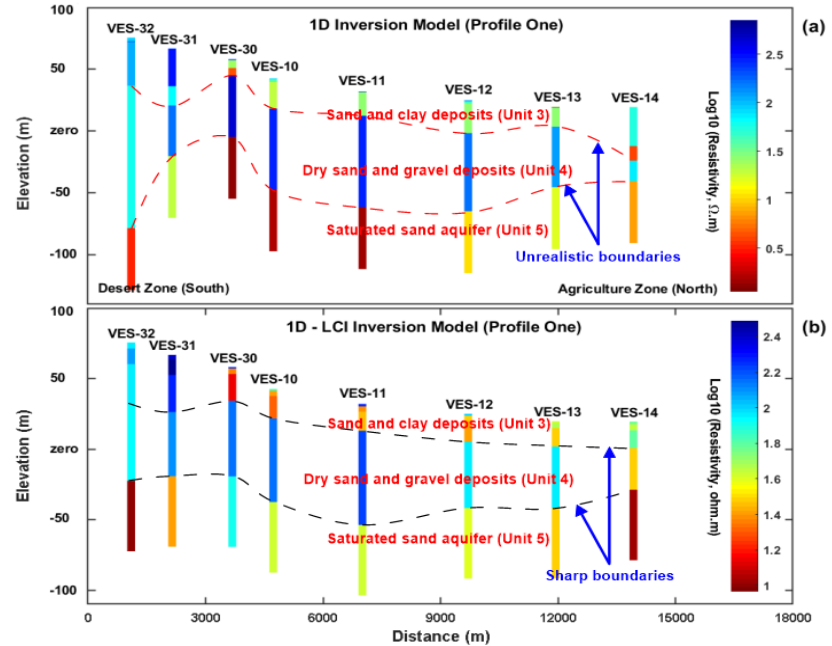
Figure 7. Inversion result from conventional 1D inversion model ( a ) and synchronized 1D–LCI inversion model ( b ) using five layers, constructed from VES soundings along profile one. Geosciences 2021 , 11 , x FOR PEER REVIEW